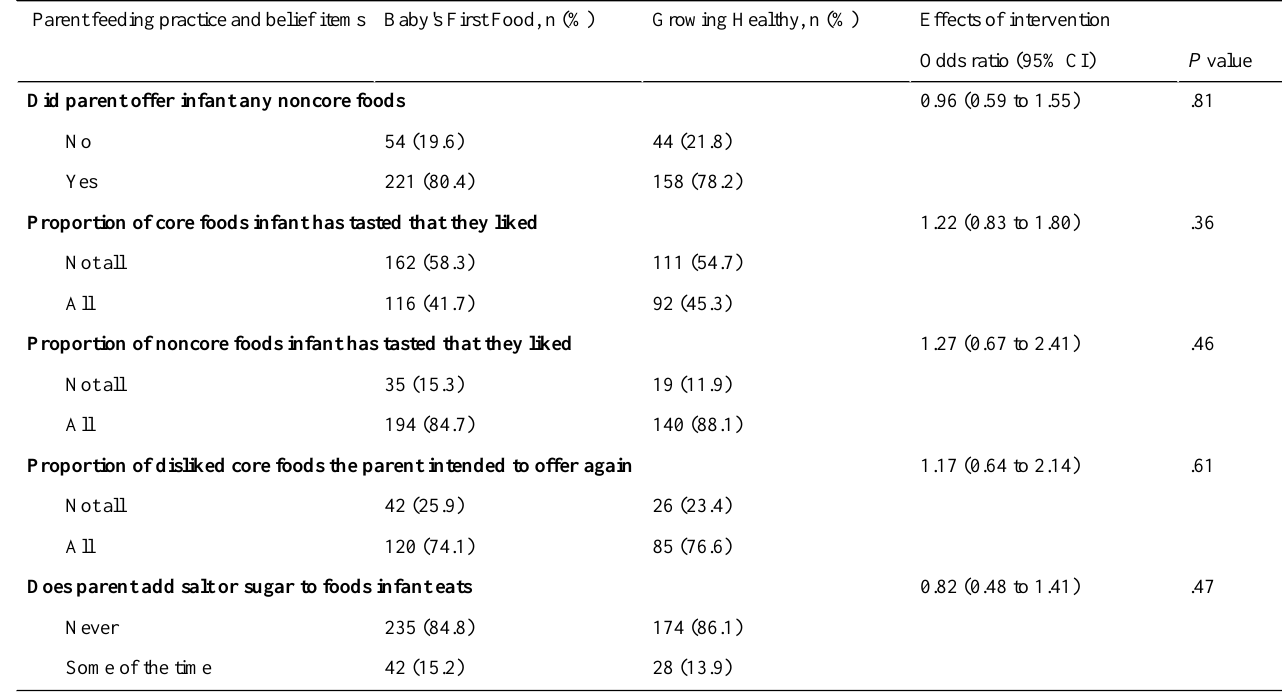
Table 5. Comparison of parent feeding practice and belief binary outcomes at time 3 between Baby's First Food and Growing